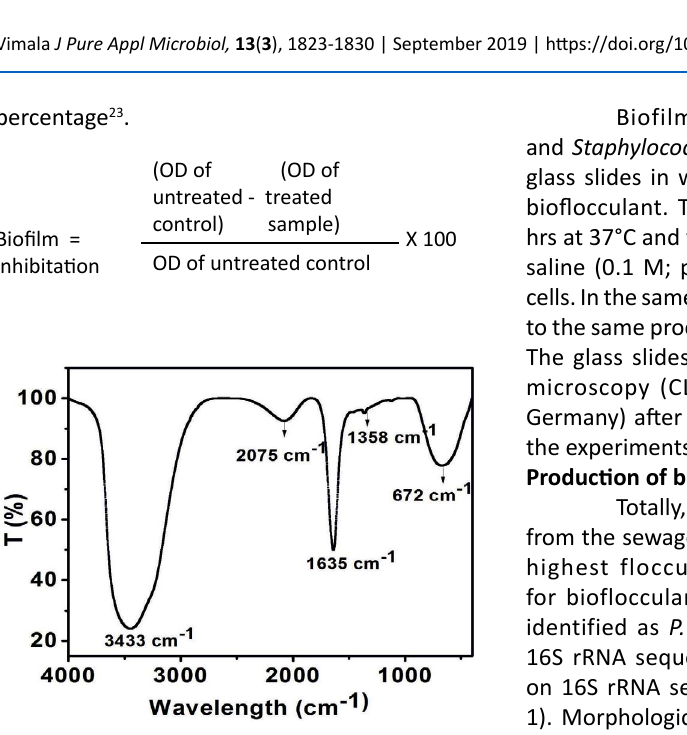
Fig. 3. FTIR spectra of bio occulant showing presence of hydroxyl, amino, and carboxylic group.